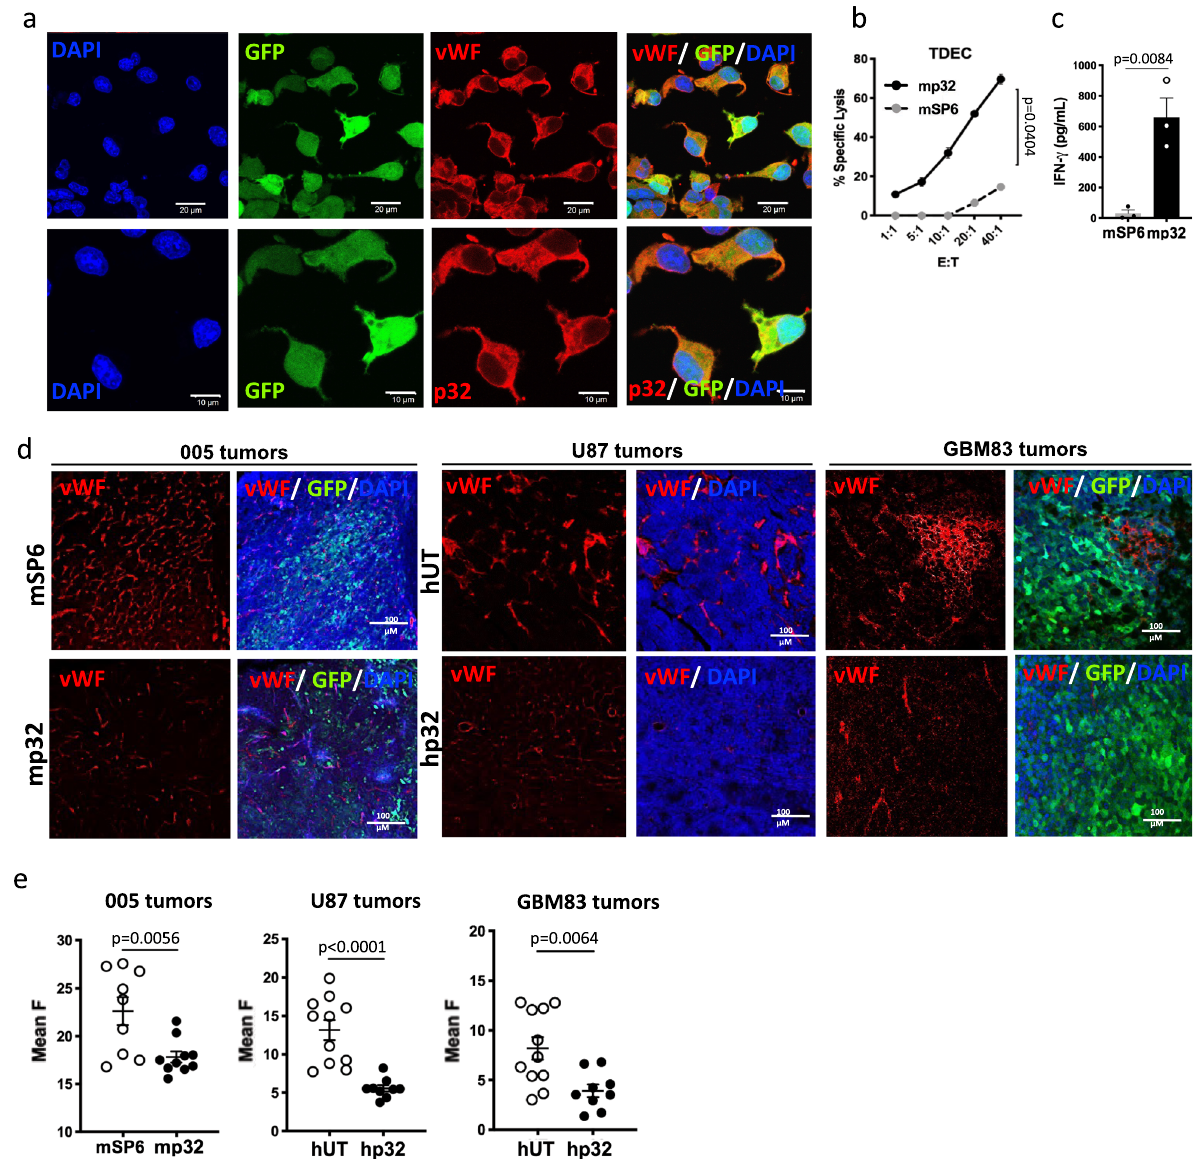
Fig. 5 P32 CARTs exert an antiangiogenic action both in vitro and in vivo. a 005 cells differentiated into tumor-derived endothelial cells (TDEC) in EGM medium with deferoxamide (DFO; to mimic hypoxia) were analyzed for Von Willebrand factor (vWF, endothelial marker) (upper panels) and p32 (lower panels) expression by confocal microscopy. Representative image of three independent experiments. b Cytotoxic action of mSP6 and mp32 (murine CAR) T cells against TDEC assessed by LDH cytotoxicity assay. Data represent mean ± SEM. N = 3 independent experiments. Unpaired t test with Welch ’ s correction was used for statistical analysis. Two-tailed P value is shown. c Recognition of TDEC by CAR T cells (measured by IFN- γ release) Data are shown as mean ± SEM, each dot is the average for an individual experiment ( N = 3). d , e Tumor tissue stained for von Willebrand factor (vWF) and analyzed by confocal microscopy shows a clear decrease of blood vessels in the p32CAR treated animals. e Quanti fi cation of vWF staining. Data are shown as mean ± SEM. Each dot shown in the graph represents average of three measurements done per slide. A total of 9 (mSP6, hp32 for both models), 10 (mp32) or 11 (hUT) slides originated from 3 different mice were stained per group. For c , e unpaired t test was used and two-tailed P value is shown. Source data are provided as a Source Data fi